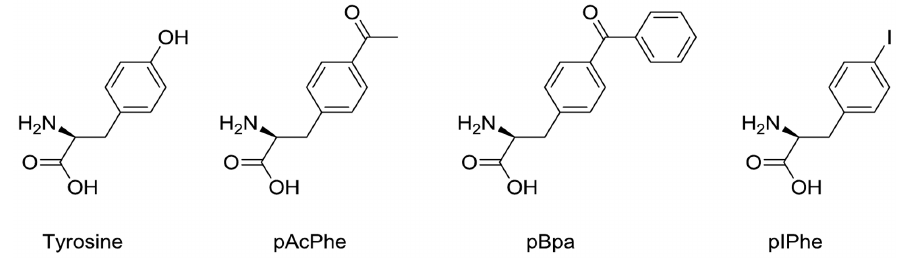
Figure 1. Structures of tyrosine and the three unnatural amino acids used in this study.